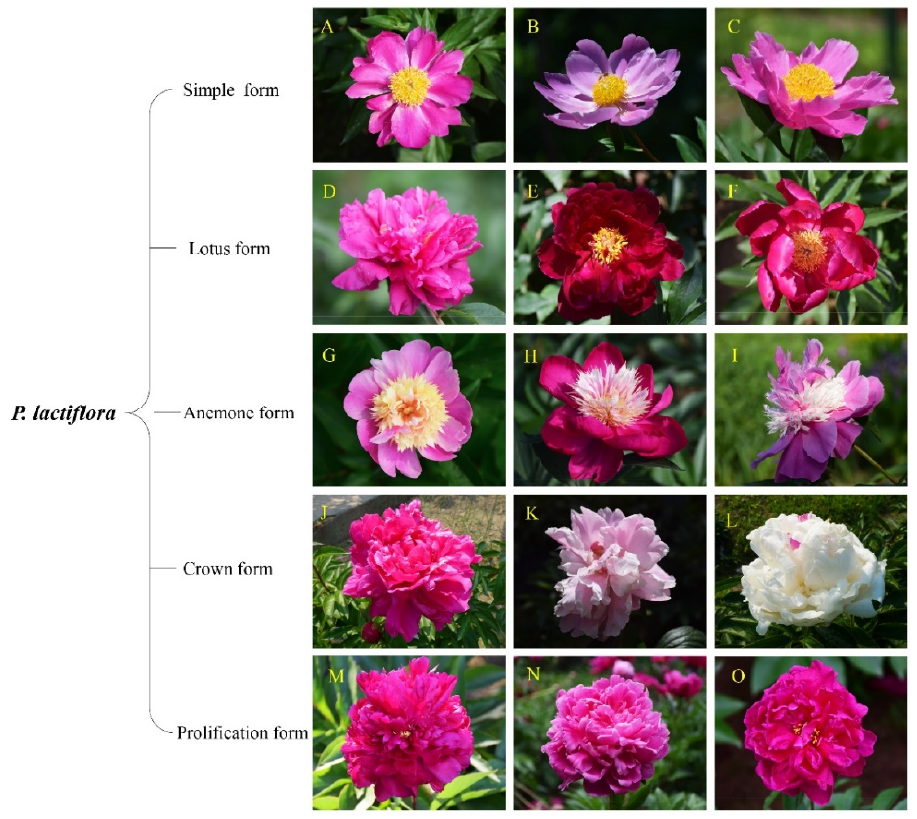
Figure 8. Fifteen P. lactiflora cultivars adopted as the material in this study. ( A ) ‘Bo Baishao’; ( B ) ‘Chishao’; ( C ) ‘Hang Baishao’; ( D ) ‘Zhuguang’; ( E ) ‘Yanzi Xiangyang’; ( F ) ‘Hongpan Tuojing’; ( G )